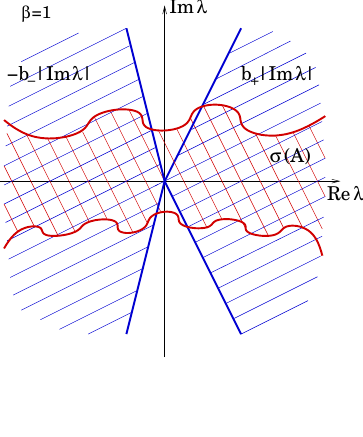
Figure 2: The case of β = 1